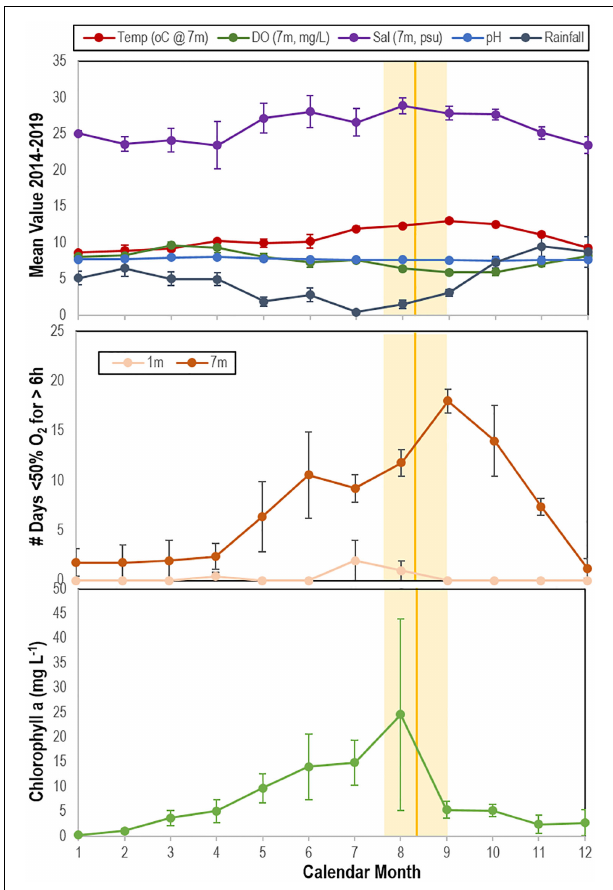
FIGURE 10 | Correspondence between mean time of wasting mass mortality (indicated by solid orange line (SE range indicated by lighter orange bar) compared with physico-chemical parameters (top), the mean number of days in which oxygen was < 50% saturation for ≥ 6 h at 1 and 7 m (middle) and mean chlorophyll a concentration (bottom) at Penn Cove, Whidbey Island from 2014 to 2019. Temp, temperature; DO, dissolved oxygen; Sal, salinity. Data was analyzed from the Penn Cove Shellfish data buoy (retrieved from